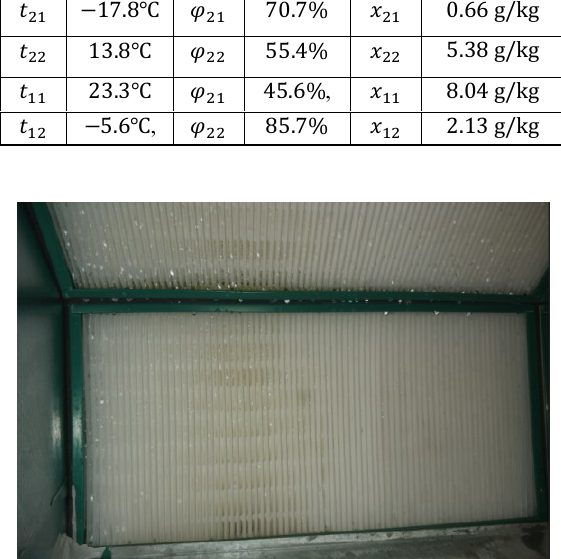
Fig. 7. The heat exchanger surface at the end of measurements.